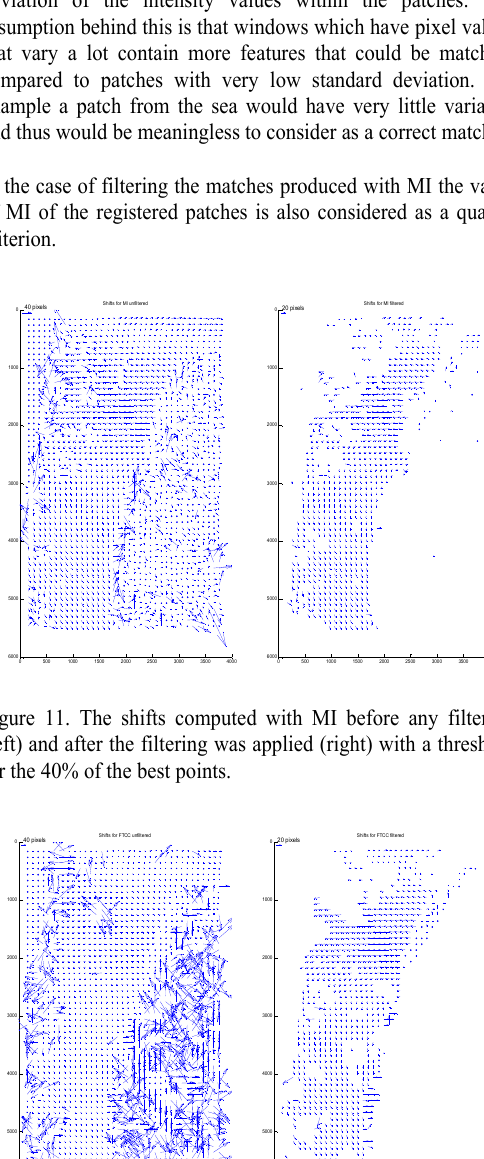
Figure 13. The remaining MI shifts (at 609 points) after comparing the filtered MI and FTCC results and keeping only the points, which were selected in both filtering